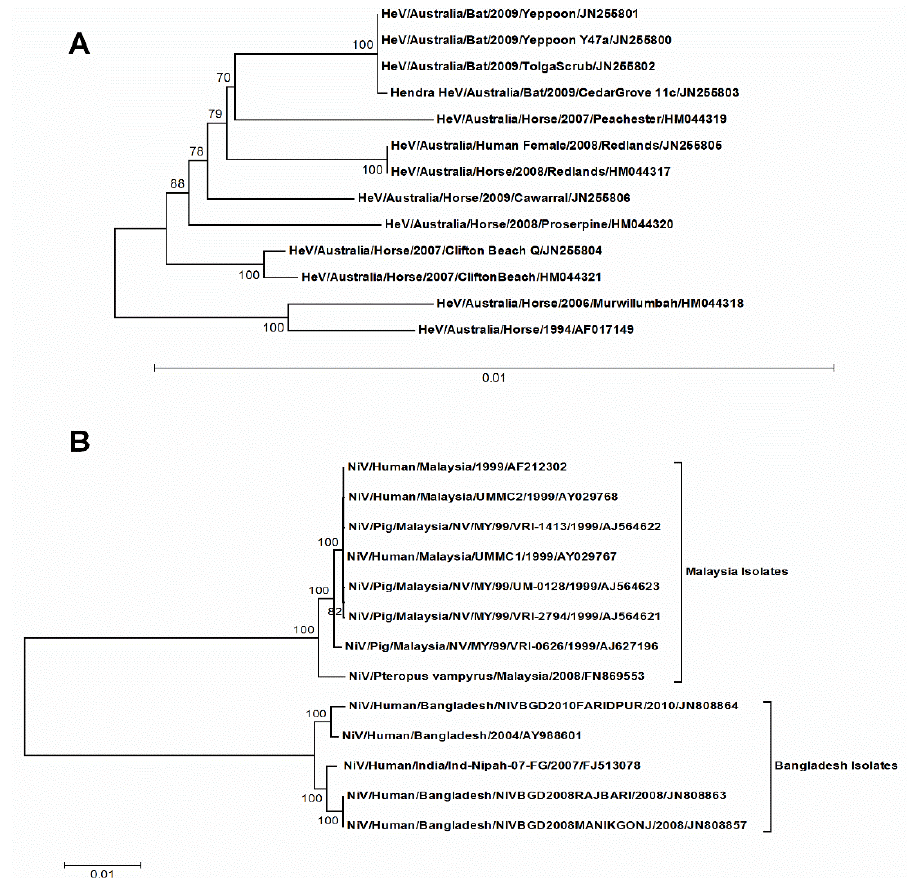
Figure 1. The maximum likelihood trees of HeV ( A ) and NiV ( B ) complete coding genomic sequences. The trees were constructed by TN93 + G substitution model implemented in MEGA software version 7. The reliability of the trees was assessed by bootstrap with 1000 replications. The bootstrap values greater than 70 are shown. Scale bars represent substitutions per site. For each strain, the following data are furnished: Virus/Species affected/Country/strain name/year of isolation/GenBank accession nos. HeV, Hendra virus; NiV, Nipah virus.